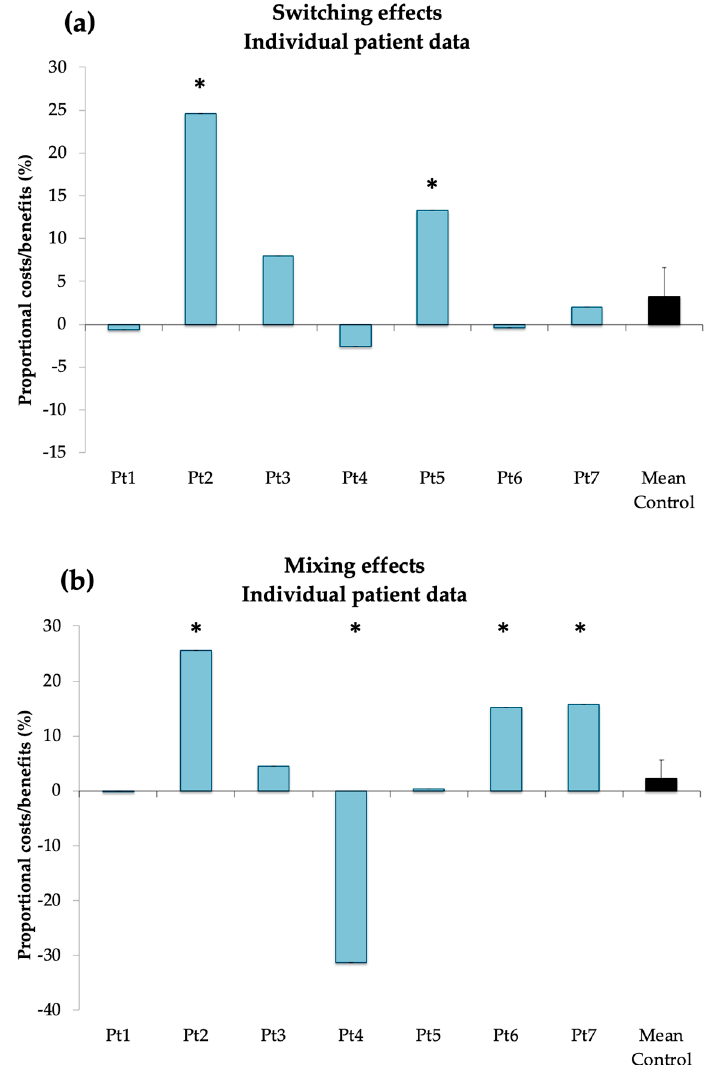
Figure 3. Individual proportional switching ( a ) and mixing ( b ) effects compared to control group mean. Significant deviation from control group mean is marked with an asterisk.